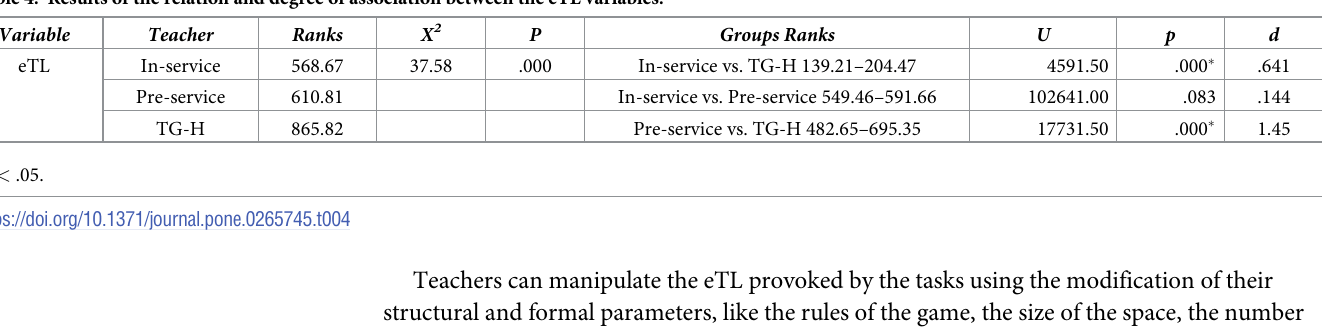
Teachers can manipulate the eTL provoked by the tasks using the modification of their structural and formal parameters, like the rules of the game, the size of the space, the number of players involved, the presence of the goalkeeper, the use of scoring, the duration of the task and/or the encouragement of the teacher. This modification of the elements that define and